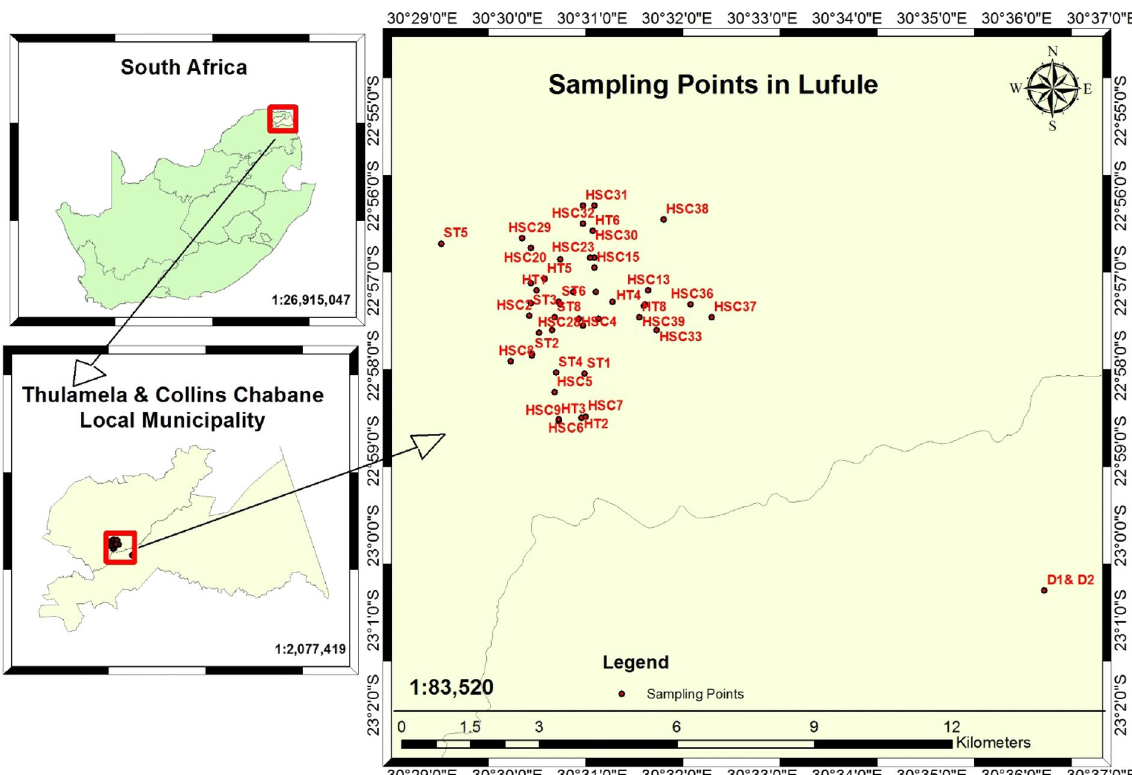
Figure 1. Map of the study area showing water samples’ collection